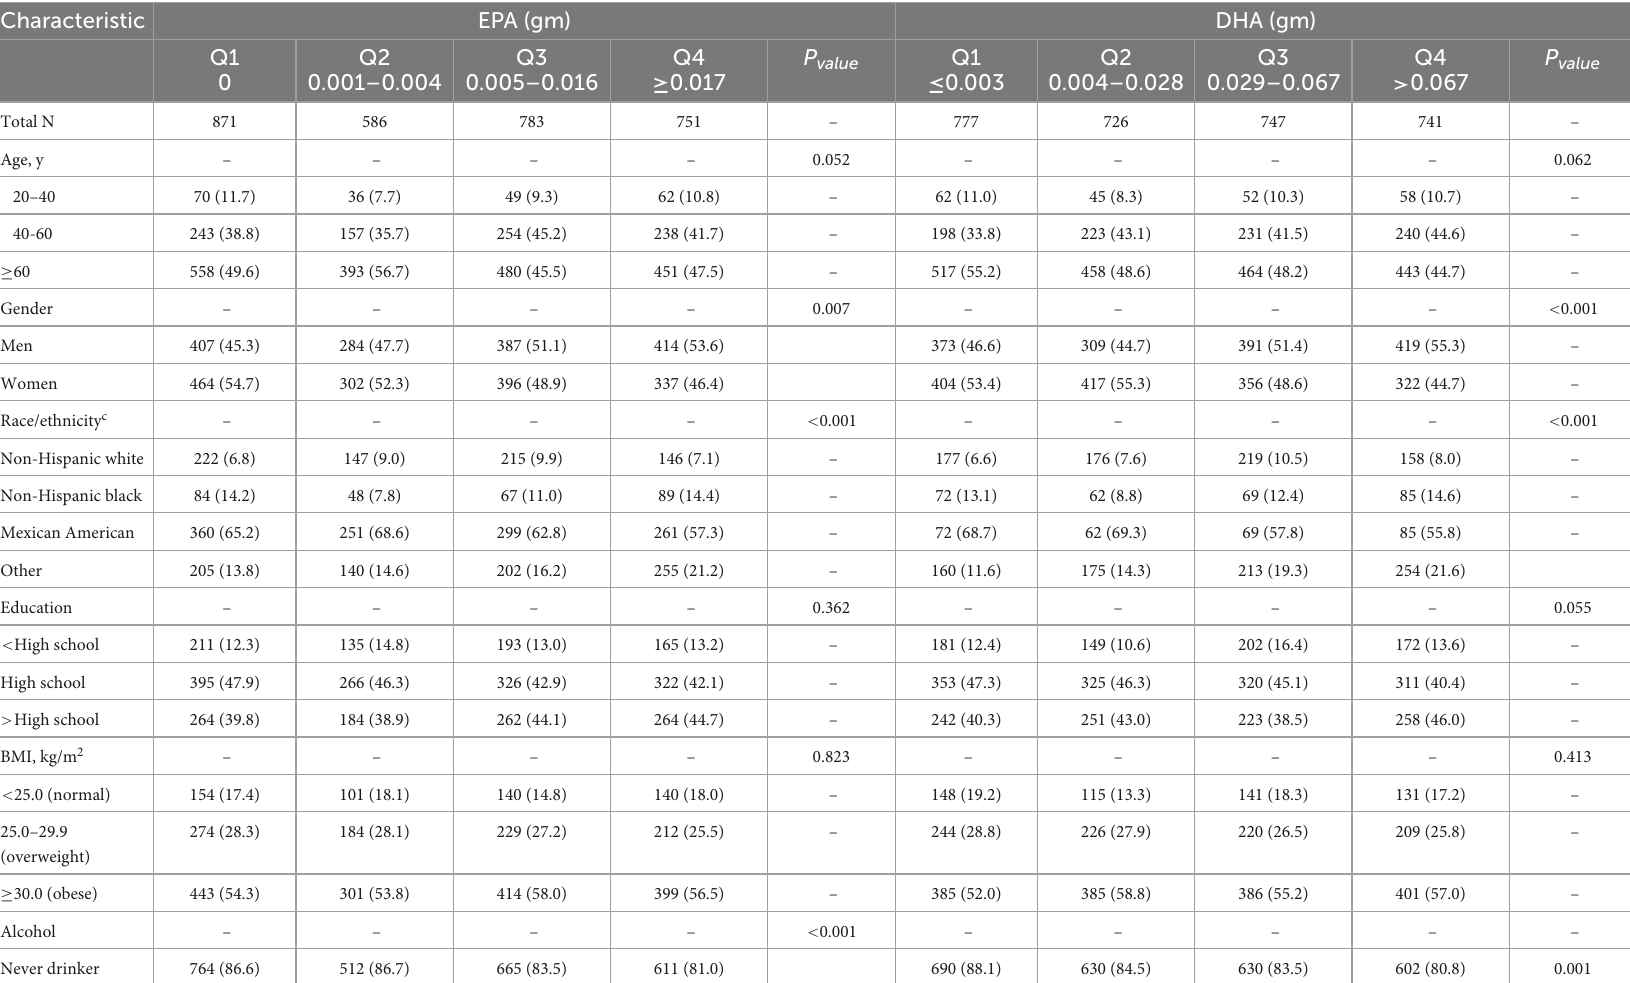
TABLE 1 Baseline demographic characteristics of the study population, according to quartiles of eicosapentaenoic acid (EPA) and docosahexaenoic acid (DHA).